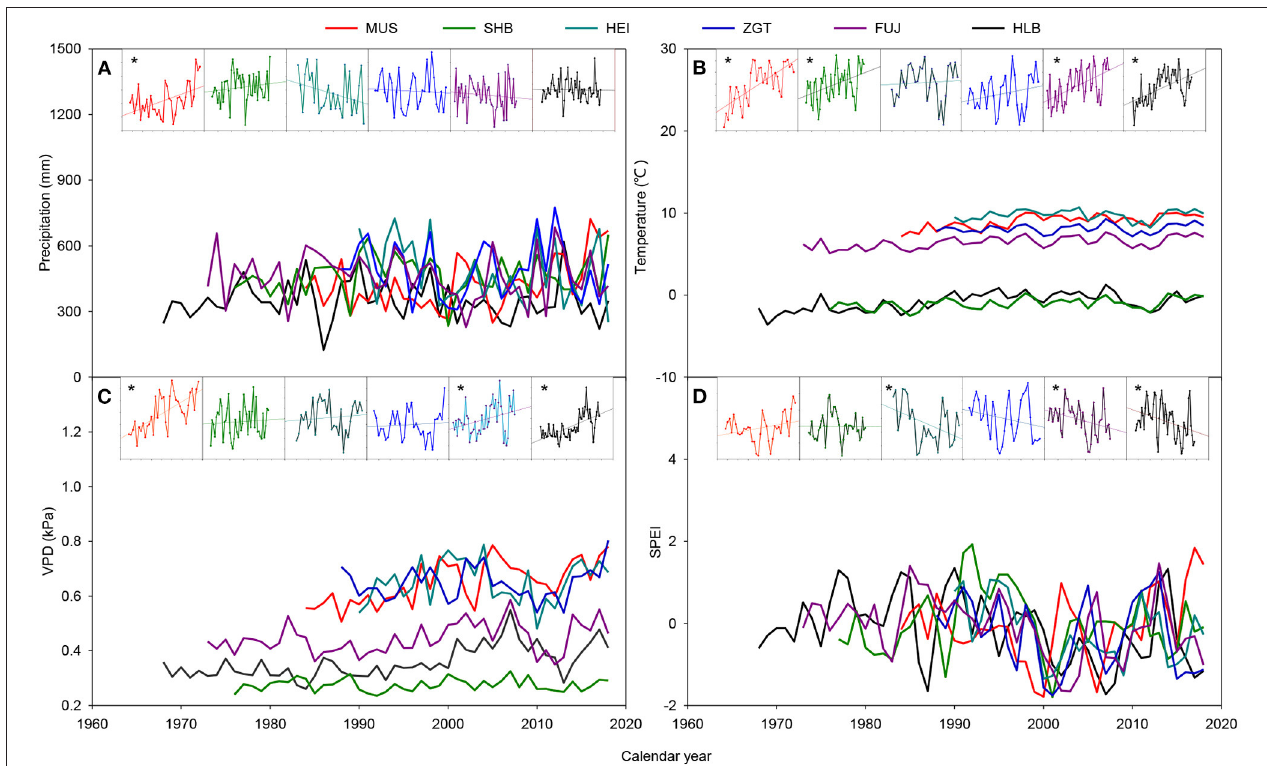
FIGURE 2 | Variation in total precipitation (A) , mean temperature (B) , mean vapor pressure deficit (VPD) (C) , and mean standardized precipitation evapotranspiration index (SPEI) (D) during the growth period at six experimental sites in the Three-North Shelter Forest. Asterisks indicate that the trend was a significant increase or decrease at p <